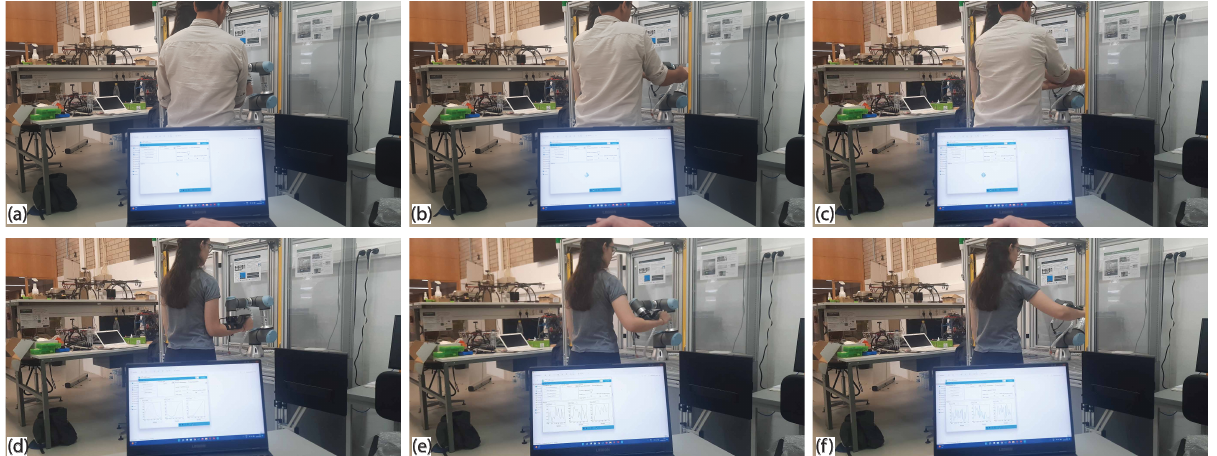
Figure 5. Custom exercise experimentation. ( a – c ) Person driving the robot and the subject’s hand, with the software recording the data. ( d – f ) The robot driving the patient’s hand following the exact path recorded, with the software displaying the force data in ( x , y , z )